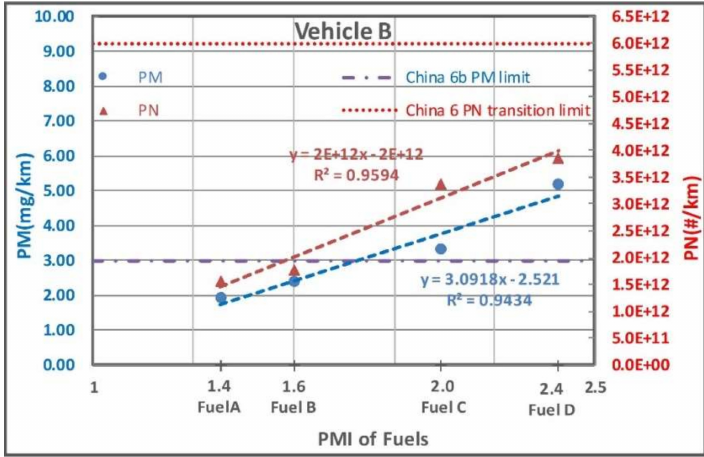
Figure 6. PMI vs. particulate mass (PM) and particulate number (PN) emissions from Vehicle B.